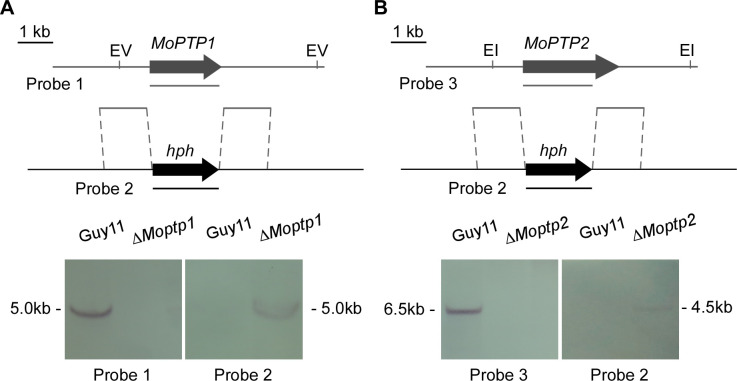
Southern blot analysis of MoPTP1 and MoPTP2 deletional mutants.Southern blot analysis of the gene knockout mutant with gene-specific probe (probe one for MoPTP1 and probe three for MoPTP2) and hygromycin phosphotransferase (HPH) probe (probe 2). The scheme of MoPTP1 and MoPTP2 gene disruption.